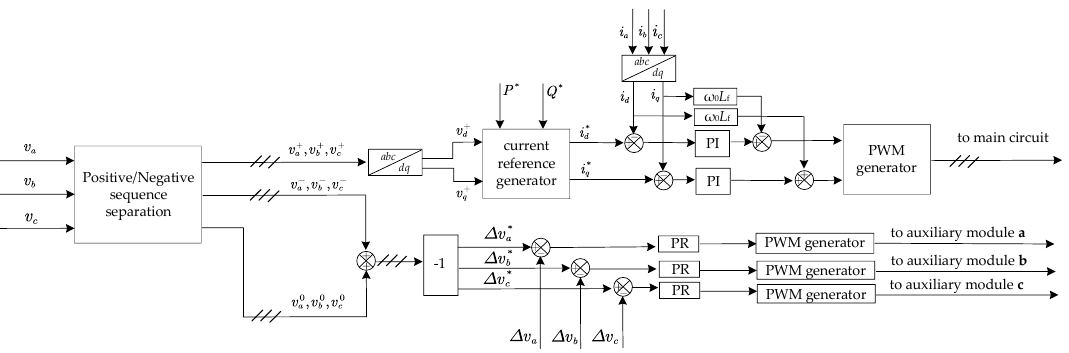
Figure 4. Overall control structure diagram.